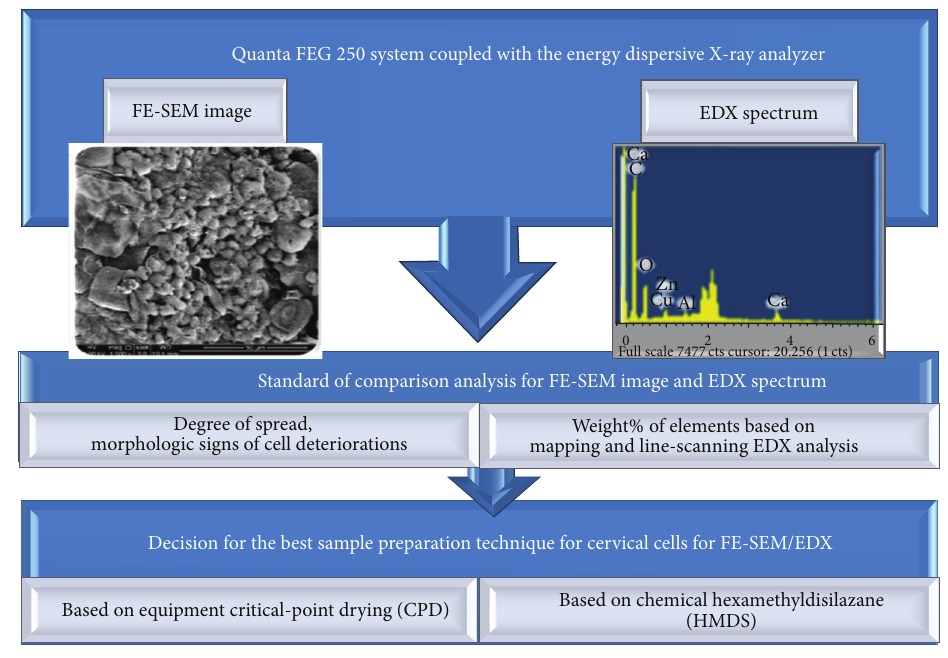
Figure 4: Analysis techniques for FE-SEM/EDX data based on CPD and HMDS preparation